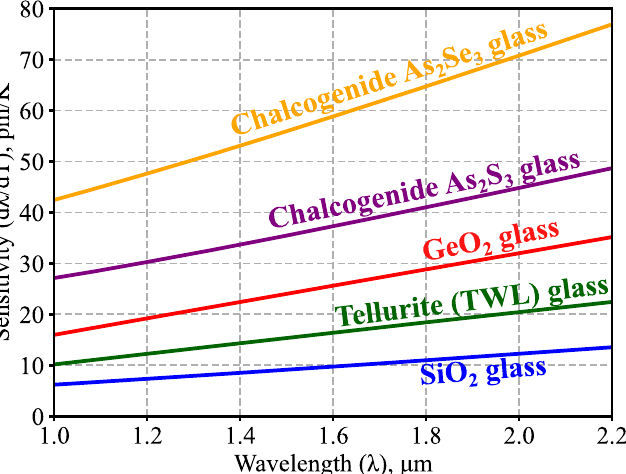
Figure 7. Calculated WGM temperature sensitivity as a function of the wavelength of light. The data are shown for room temperature conditions ( T 0 = 293 K) for microspheres with R 0 = 100 μ m.